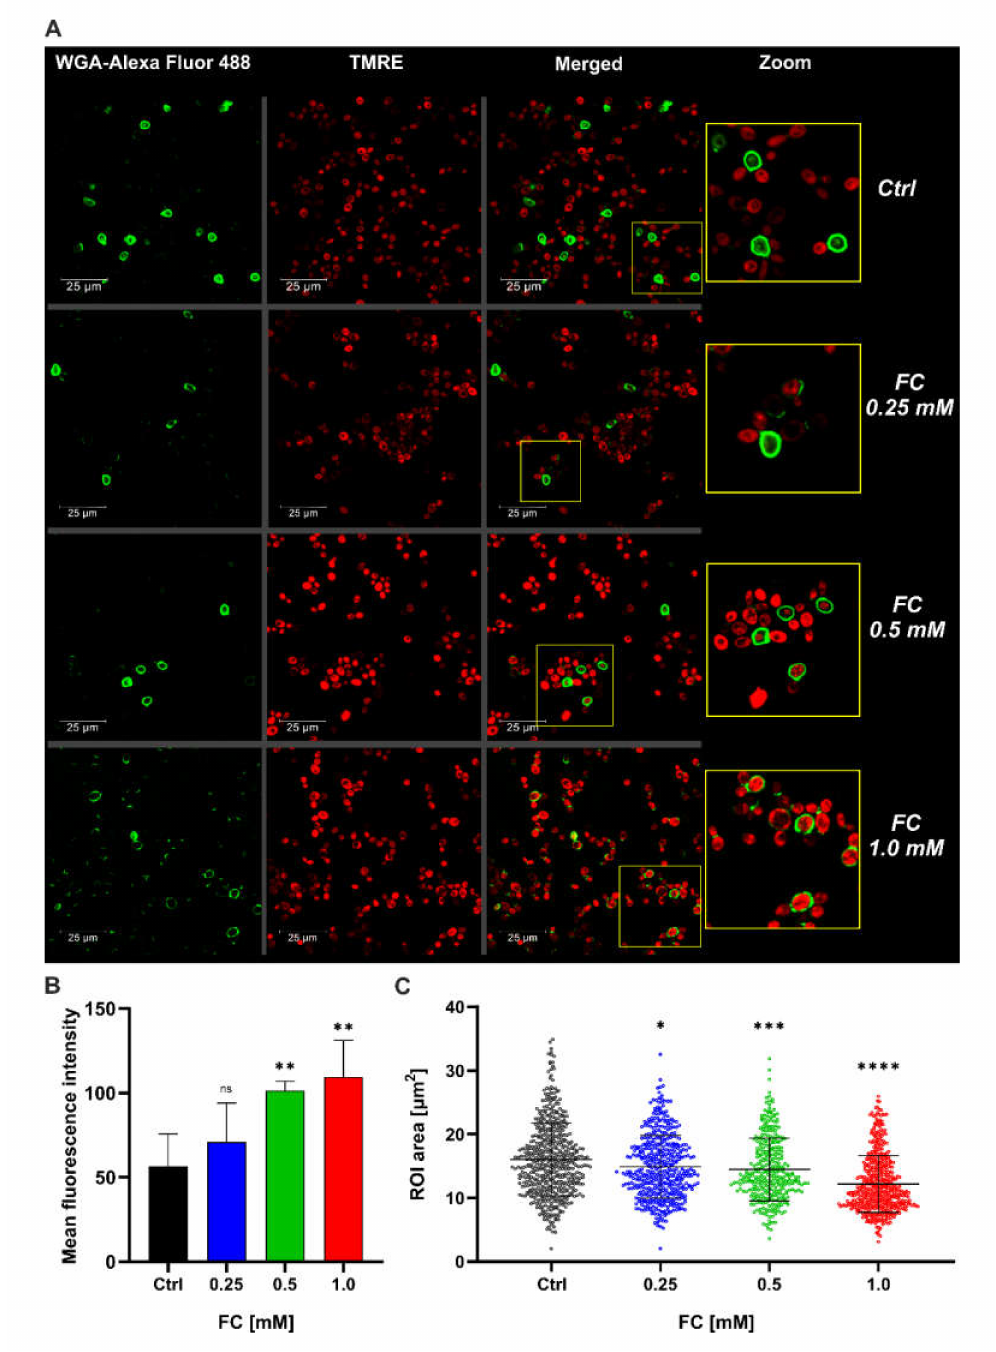
Figure 3. Analysis of FC influence on the mitochondrial membrane potential and cell size of aged yeast (day 14 of CLS assay). ( A ) Confocal microscopy analysis of yeast maturity and cell size. Intensity of TMRE red fluorescence corresponds to the energetic state of mitochondria (ex/em: 543/570–610 nm). Green fluorescence of WGA-Alexa Fluor 488 indicates bud scars (ex/em: 488/500–560 nm). ( B ) Bar graph presents changes in mean fluorescence intensity of TMRE. Data are presented as mean ± SD of three independent experiments. ( C ) Size of yeast cells evaluated using the ROI area. Number of samples: Ctrl = 544; 0.25 mM FC = 485; 0.5 mM FC = 342; 1.0 mM FC = 541. Statistical significance versus control (ANOVA): (ns) non − significant, (*) p < 0.05, (**) p < 0.001, (***) p < 0.001, (****) p <